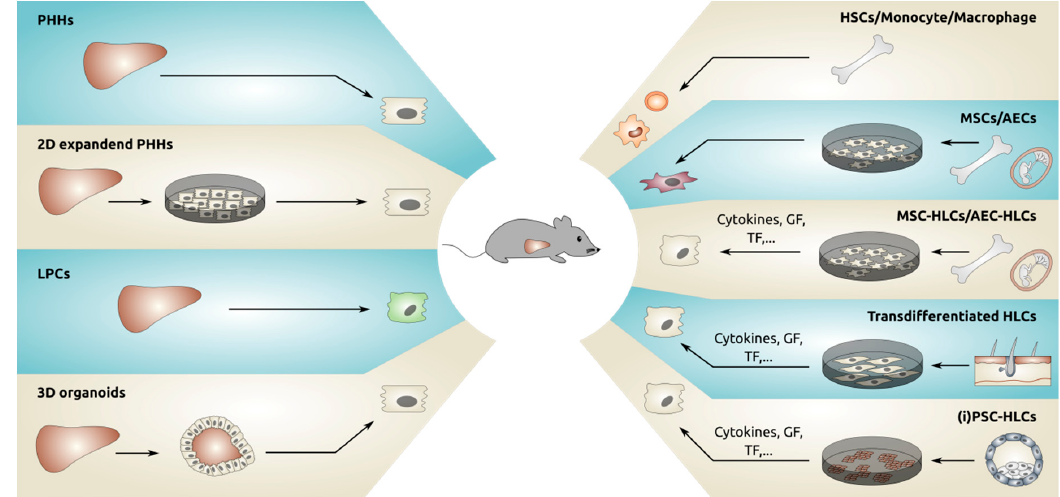
Figure 1. Different sources of cells that have been transplanted in mouse livers. GF = growth factors, TF = transcription factors, PHHs = primary human hepatocytes, LPCs = liver progenitor cells, HSCs = hematopoietic stem cells, MSC = mesenchymal stromal cells, AEC = amniotic epithelial cells, iPSC = induced pluripotent stem cells, HLCs = hepatocyte-like cells.